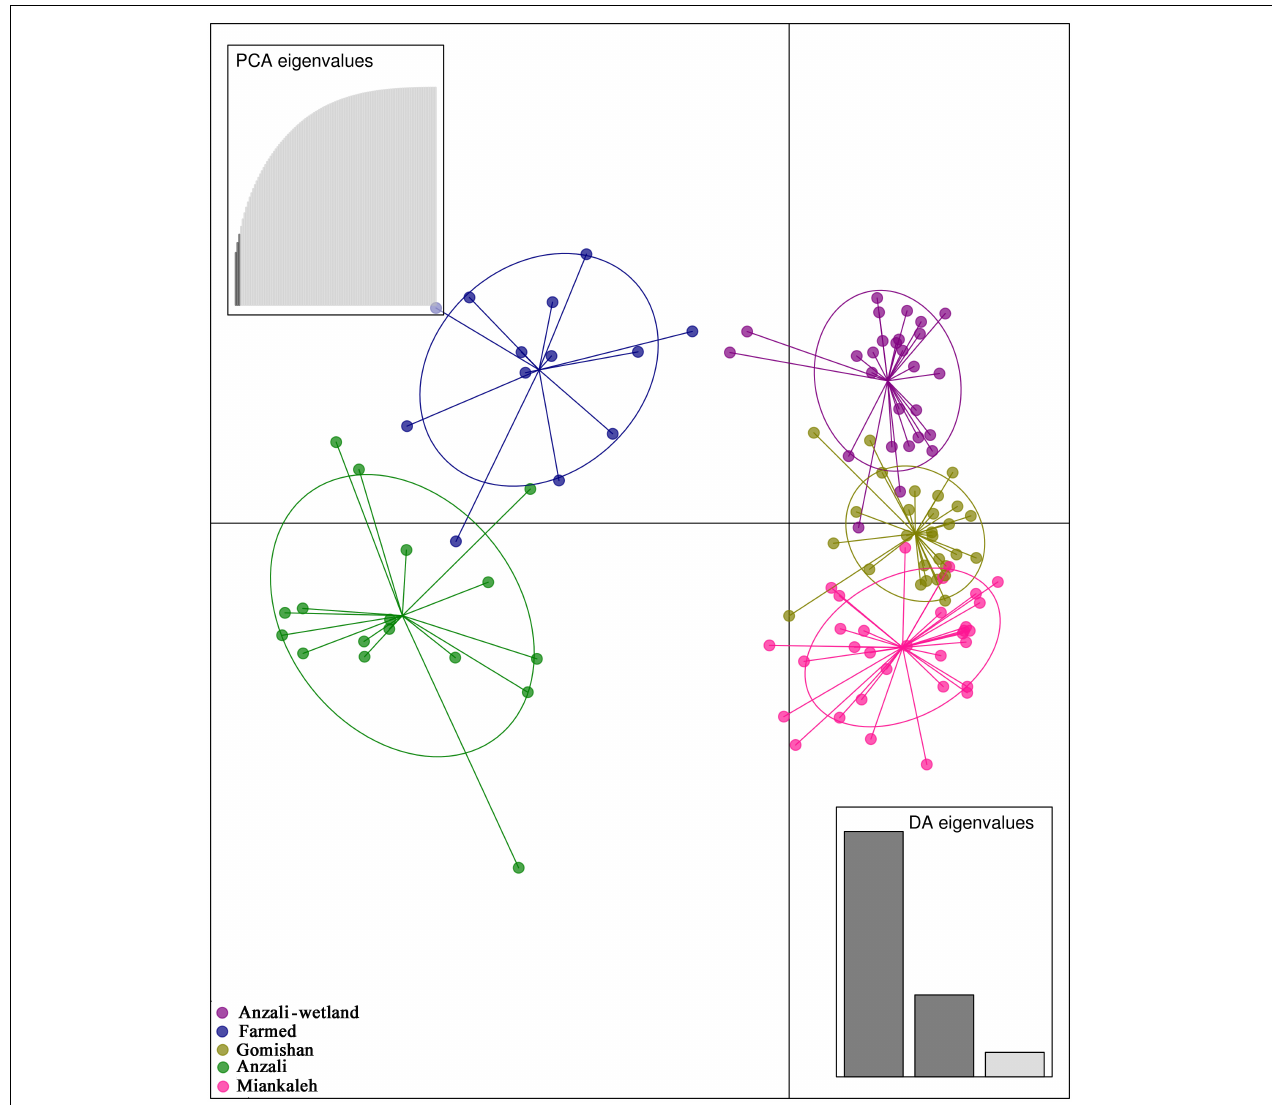
FIGURE 7 | Discriminant analysis of principal components (DAPCs) scatter plot based on the outlier loci (240 SNPs) found through BayeScan.